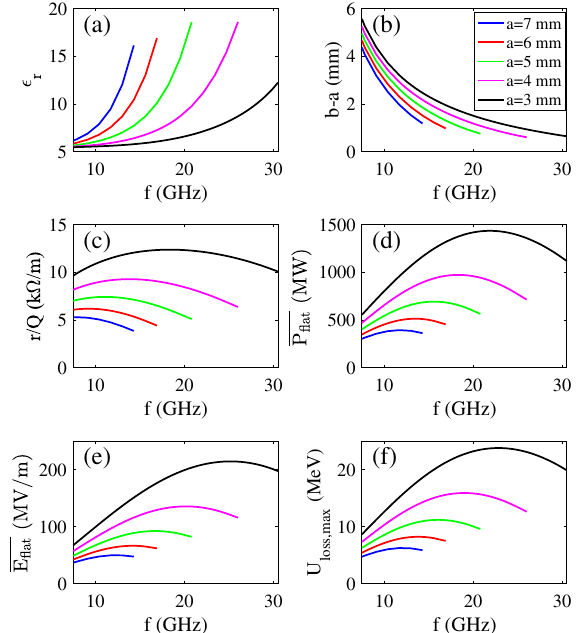
FIG. 17. EM and wakefield properties of the uniform section as a function of the operation frequency with various inner radii. (a) Dielectric constant. (b) Dielectric thickness. (c) r=Q . (d) P (e) E . (f) Maximum U . flat loss